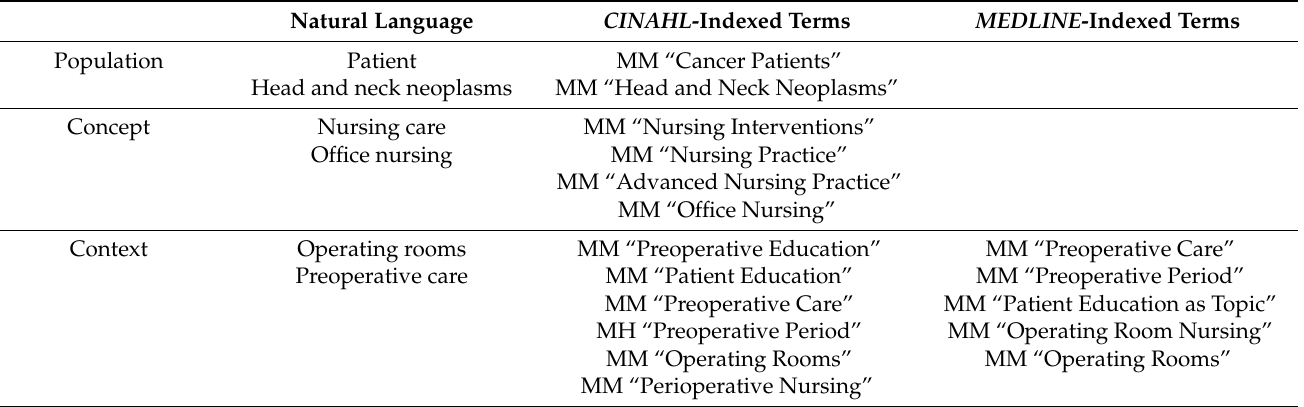
Table 2. Indexed terms selection strategy.